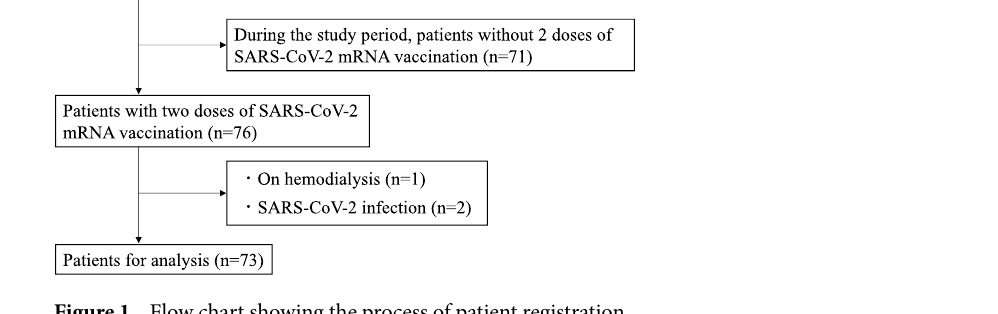
Figure 1. Flow chart showing the process of patient